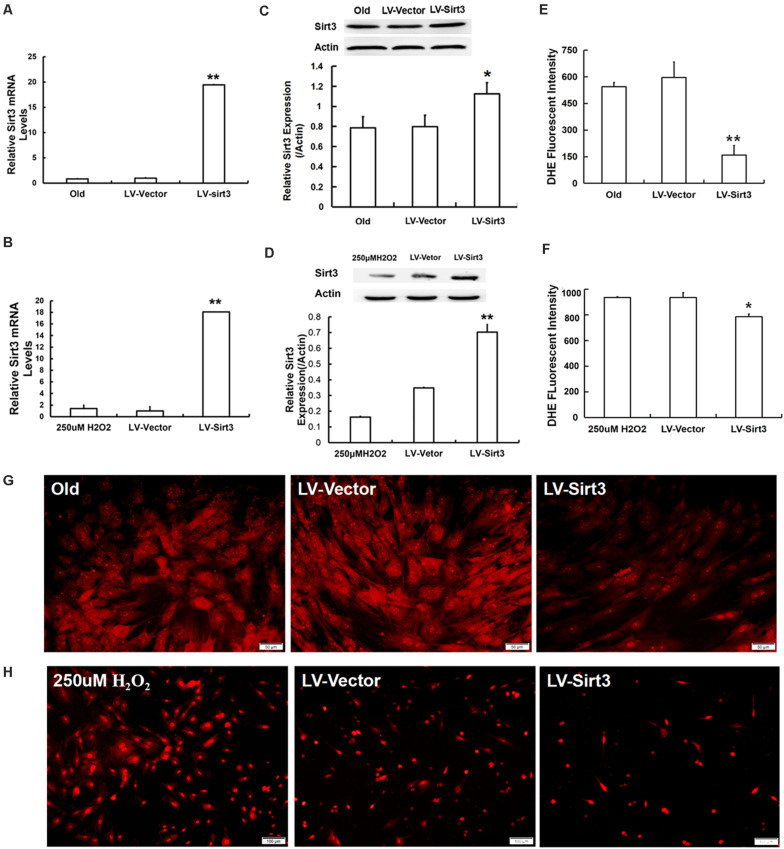
Sirt3 replenishment improves ROS scavenging ability. (A,B) Sirt3 mRNA expression was determined by RT-qPCR in old MSCs (A) and H2O2-pretreated MSCs (B) after Sirt3 over-expression. (C,D) Sirt3 protein expression was tested by western blotting. (E–H) DHE fluorescence intensity was detected by flow cytometry and microphotography. Data are expressed as mean ± SD, n = 3. *P < 0.05, **P < 0.01 vs. old or H2O2.